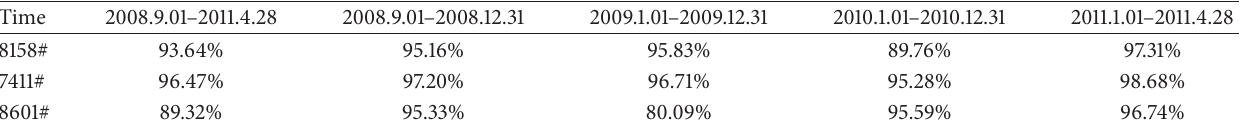
Table 2: Valid data’s rate of three meteorological stations.